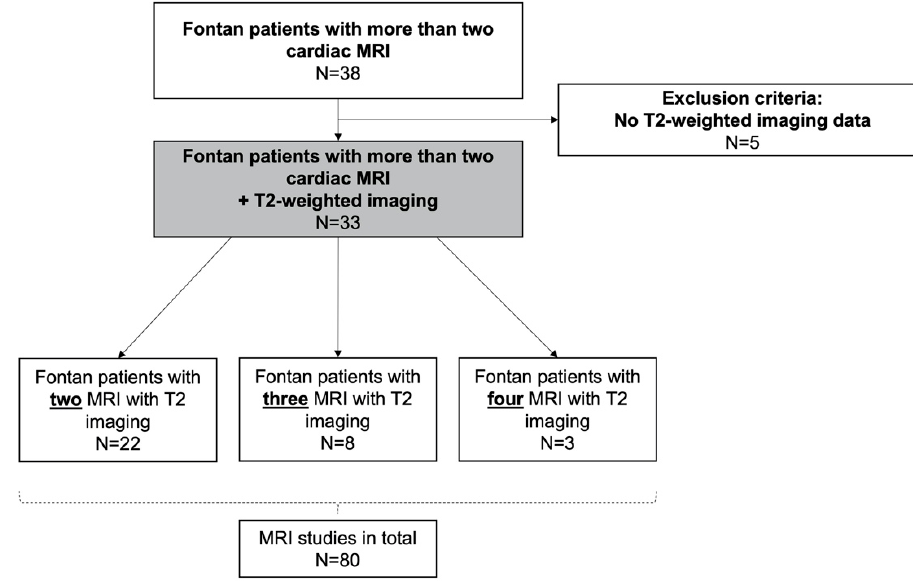
Figure 1. Flow diagram of study population.